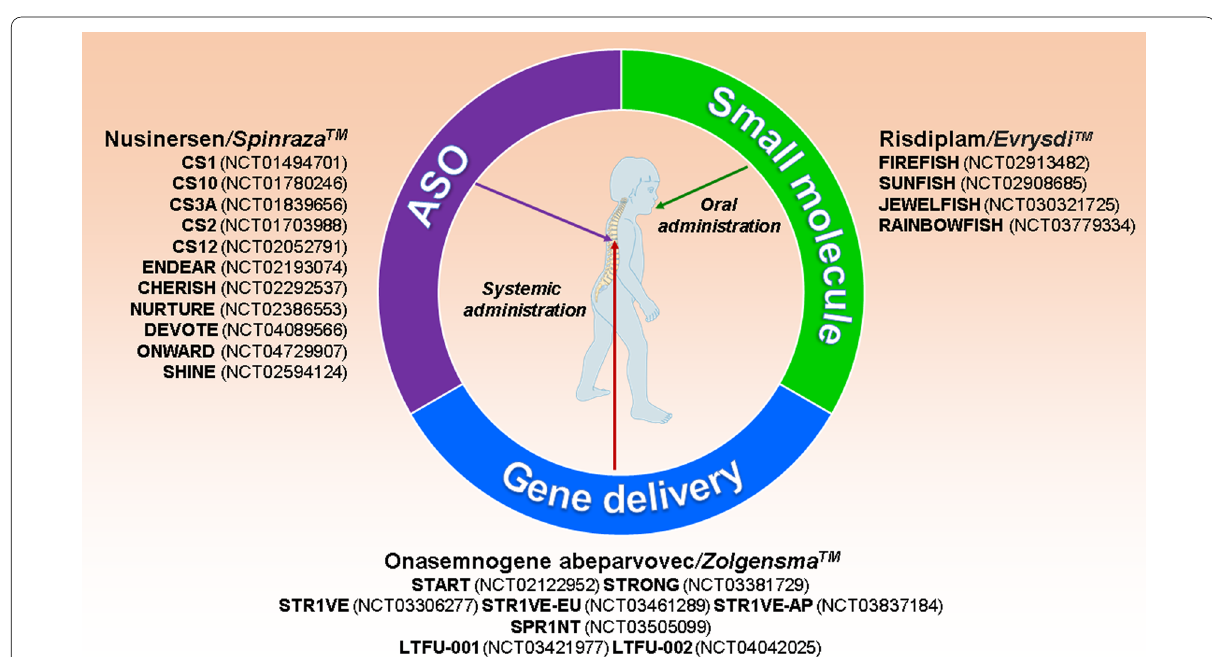
Fig. 2 Gene therapies in SMA. Overview of the currently available therapies for spinal muscular atrophy (SMA): Antisense Oligonucleotide (ASO: Nusinersen), small molecule (Risdiplam), AAV9 gene delivery approach (Onasemnogene abeparvovec)—and corresponding clinical